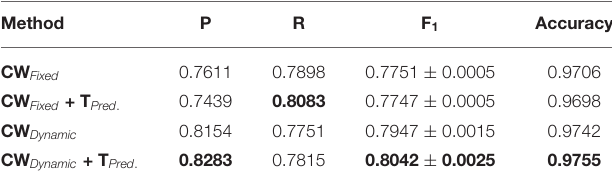
TABLE 4 | Results on AV-WIDE dataset.